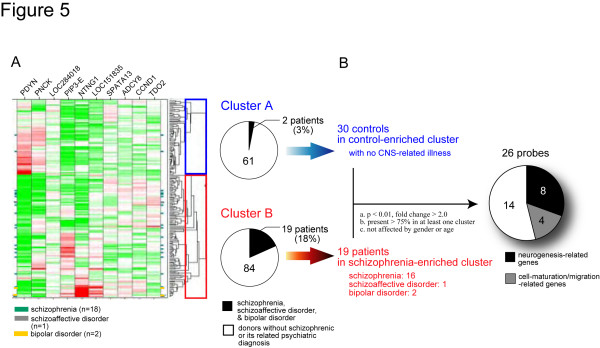
Clustering of Human Post-Mortem Brains by Biomarkers Derived from Alpha-CaMKII+/- Mice. (A) We selected 10 genes (ADCY8, CCND1, LOC151835, LOC284018, NTNG1, PDYN, PIP3-E, PNCK, SPATA13 and TDO2), which were differentially expressed in the mutant hippocampus, as a set of biomarkers to characterize the mutants, and performed the statistical clustering of the expression data of these 10 genes in 166 hippocampi of human post-mortem brains. The cluster analysis classified the subjects into two clusters (Cluster A and Cluster B), and Cluster B contained significantly more schizophrenic, schizoaffective and bipolar patients than Cluster A (P = 0.0041, χ2 test). (B) We compared the gene expression profile between the schizophrenic patients in Cluster B (= schizophrenia-enriched cluster) (n = 19) and the controls with no major psychiatric diagnosis and no CNS-related illness in Cluster A (= control-enriched cluster) (n = 30), using the following criteria; (i) gene expression level was significantly different between two groups (p < 0.01, fold change > 2.0), (ii) present flags were marked in over 75% of hippocampi in at least one of the two groups, (iii) gene expression was not affected by age and gender. We found that 26 probes met these criteria and nearly half of them encoded genes which are known to be involved in neurogenesis or cell-migration/maturation.